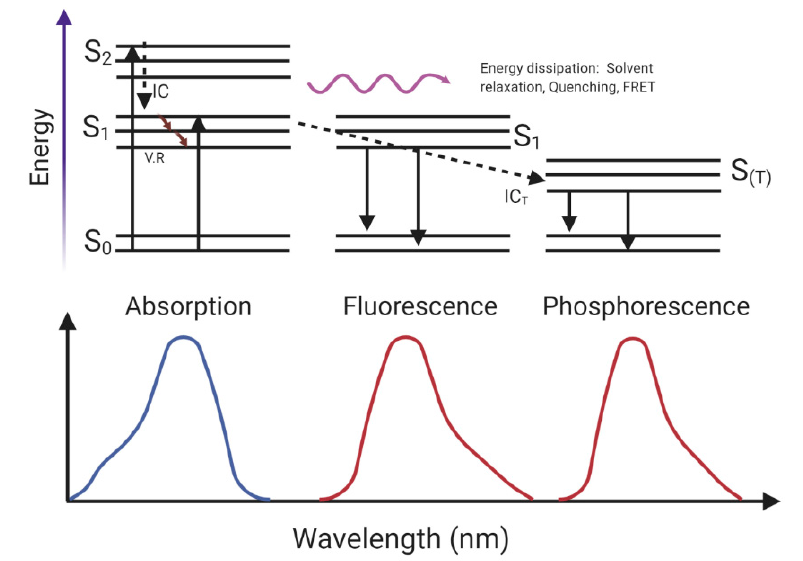
Figure 5. Simplified representation of the fluorescence and phosphorescence phenomena. The ground (S 0 ) and excited states (S 1 and S 2 ) of a fluorophore are represented. The emission of fluorescence requires 10 − 9 s, while phosphorescence emission occurs from the triplet state (S (T) ) in > 10 − 3 s. For a detailed description, see text. This figure was created with Biorender.com.